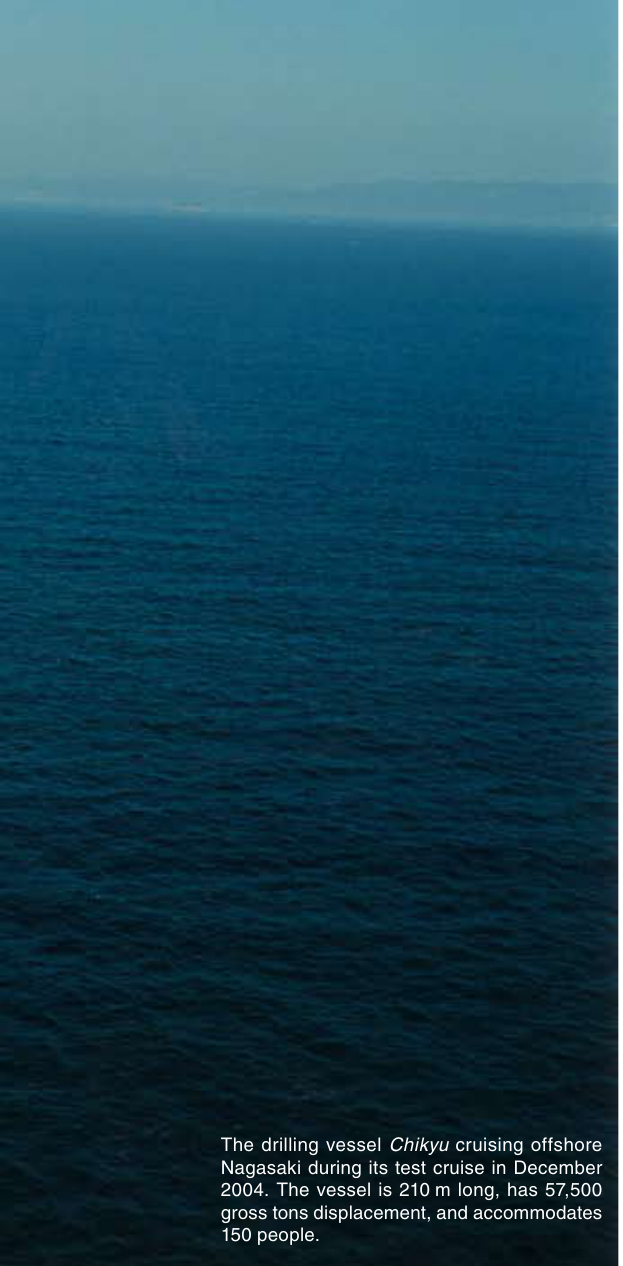
Photo courtesy of Japan Agency for Marine-Earth Science and Technology